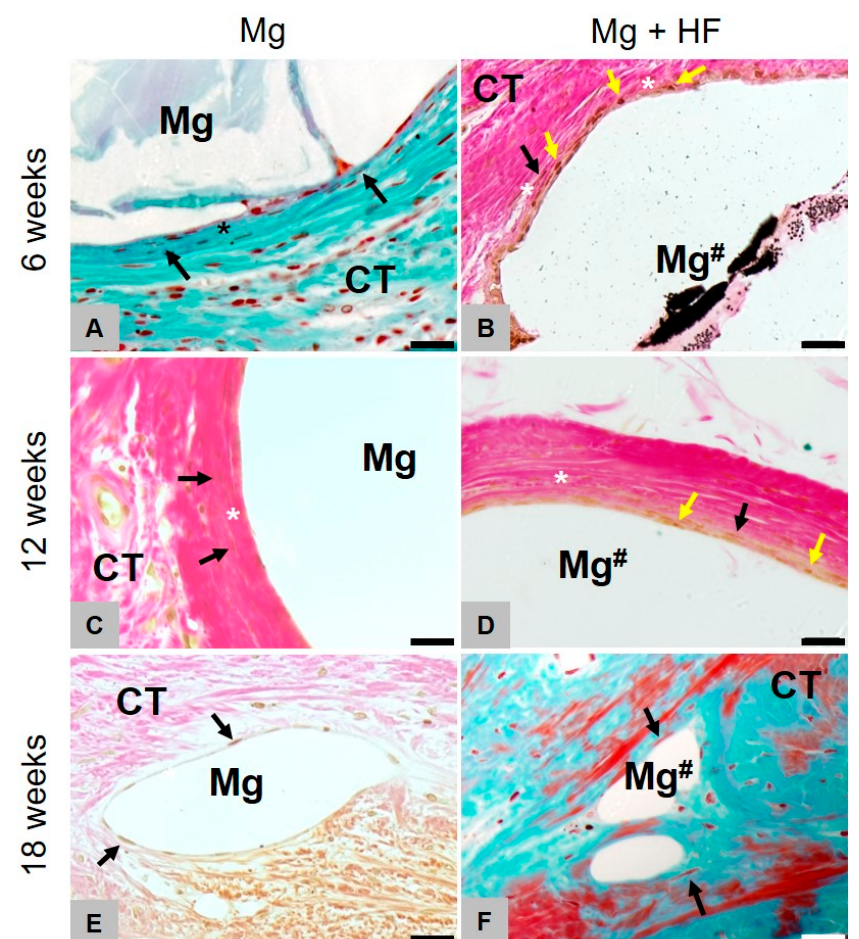
Figure 7. Gas cavity formation of HF- and untreated membranes.Representative images of Masson-Goldner ( A , F ) and Von Kossa ( B – E ) staining (40 × ) of the implantation site (scalebar = 20 µm) at 6, 12 and 18 weeks. Left for untreated (Mg) and right for HF-treated (Mg # ) magnesium. Fibrotic capsule forming ( * ) is visible at all times whereas gas cavity formation ceased to show after 12 weeks. The HF-coated mesh was mainly degraded by mononuclear cells (yellow arrows) up to 12 weeks, while the uncoated magnesium meshes elicited a fibrosis-like tissue reaction showing fibroblast accumulation (black arrows). Starting from 18 weeks after implantation, the tissue reaction in both groups was similar. Yellow arrows = phagocytic cells, black arrows = fibroblasts, asterisks = slight fibrosis.